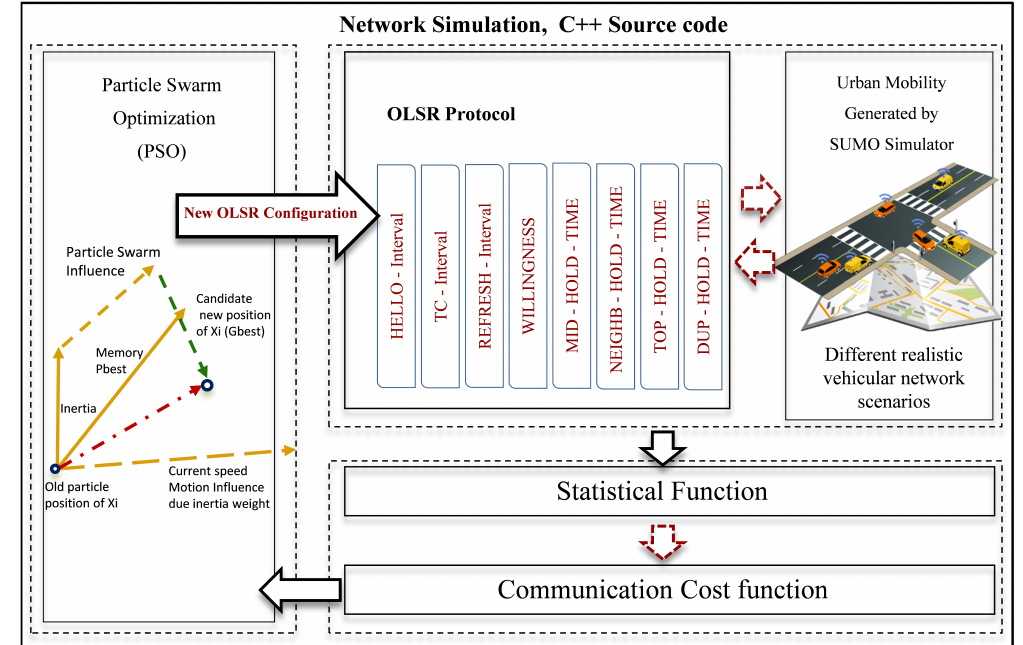
Figure 2. Framework Model for Optimization Routing Performance.